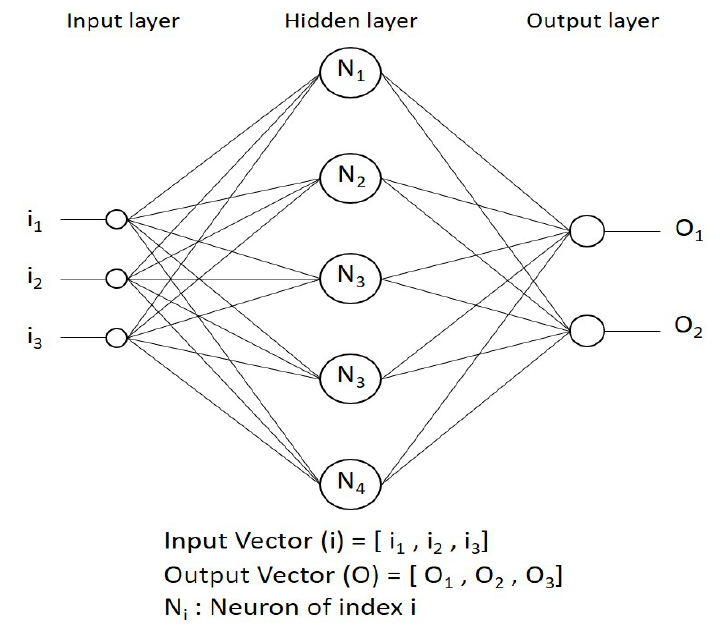
Figure 6. A Multi-layer Perceptron map with connected